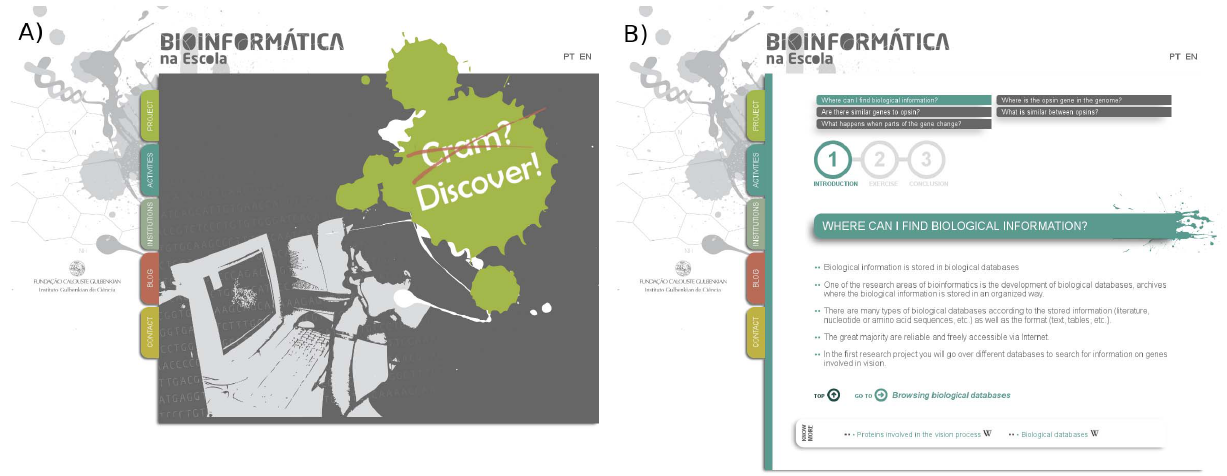
Figure 1. The Bioinformatics@school web portal. ( A ) Screenshots of the home page. ( B ) Screenshots of exercises pages.